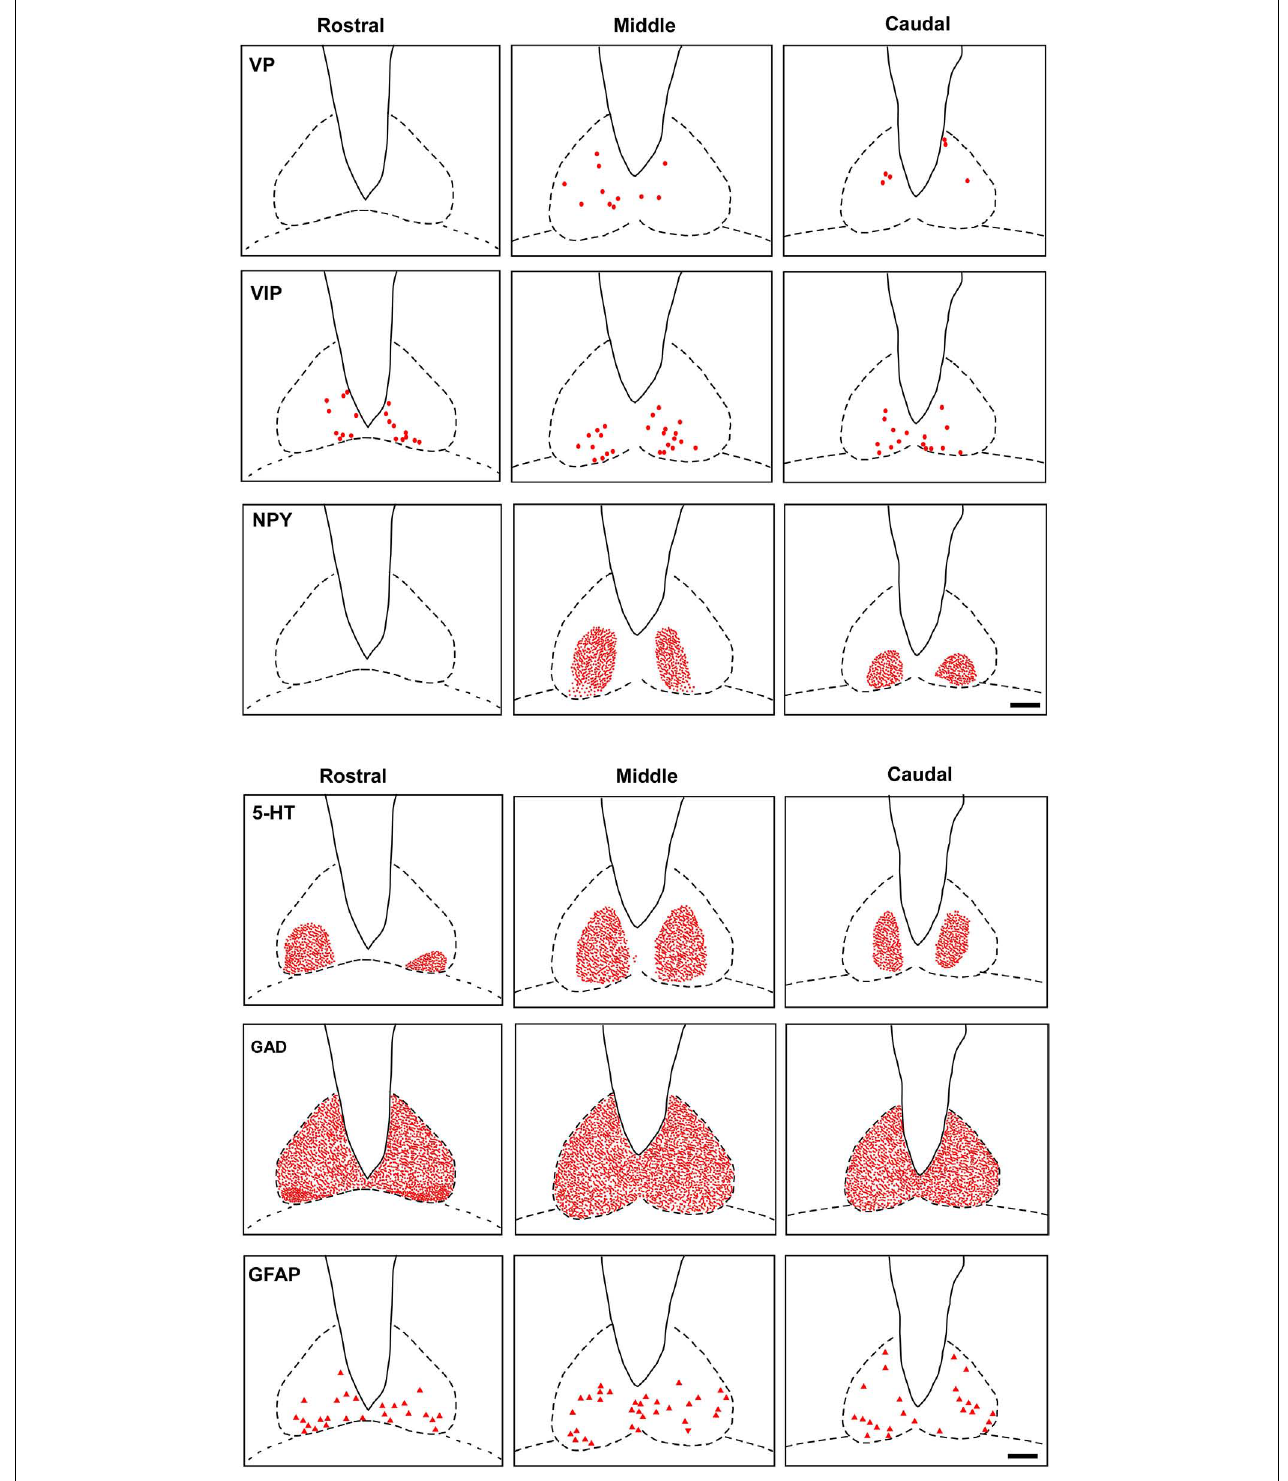
FIGURE 5 | Schematic representation of the distribution of VIP, VP, NPY, 5-HT, GAD, GFAP cells and fibers-IR at three rostrocaudal levels through the SCN. Dots represent perikarya. Square and line represent fibers and terminals. Triangle represents astrocytes. oc, optic chiasm; 3v, third ventricle; SCN, suprachiasmatic nucleus. Scale bar 100 µ